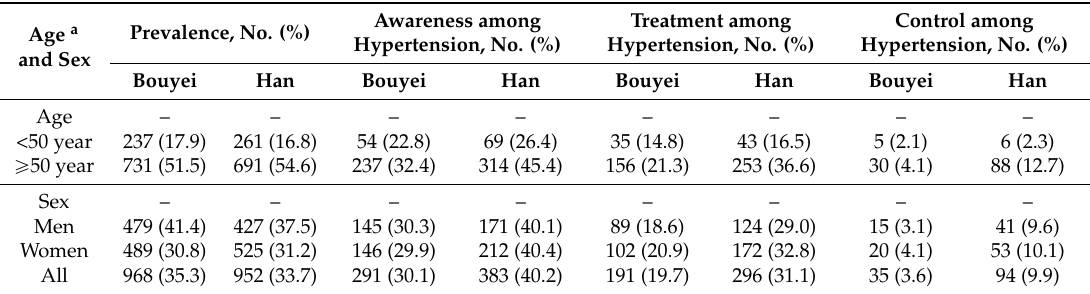
Table 2. Prevalence and control of hypertension by ethnicity, sex, and